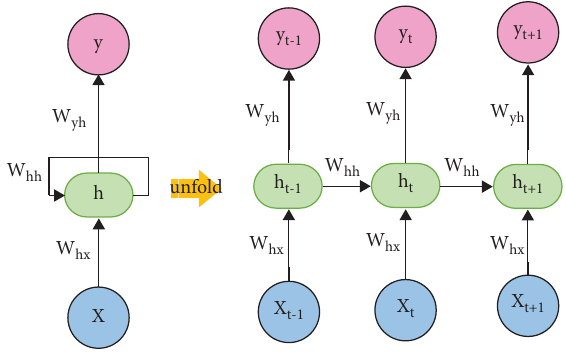
Figure 1: The architecture of